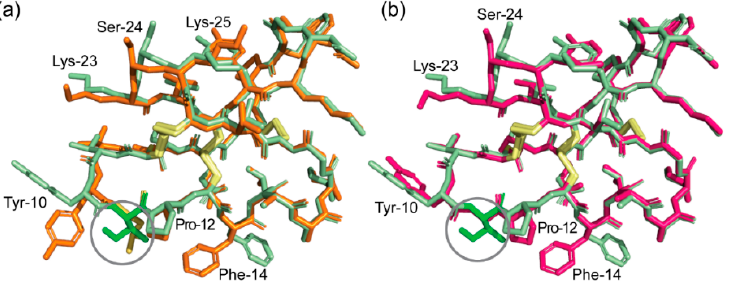
Figure 7. Racemic and quasi-racemic crystallography of [I11L]hD (7RII) and [I11G]hD (7RIJ). ( a ) Superimposition of hyen D (green) with [I11L]hD (orange). The Leu and Ile residues in loop 2 are highlighted in the circle. ( b ) Superimposition of hyen D (green) with [I11G]hD (hot pink). The Ile and Gly residues in loop 2 are highlighted in the